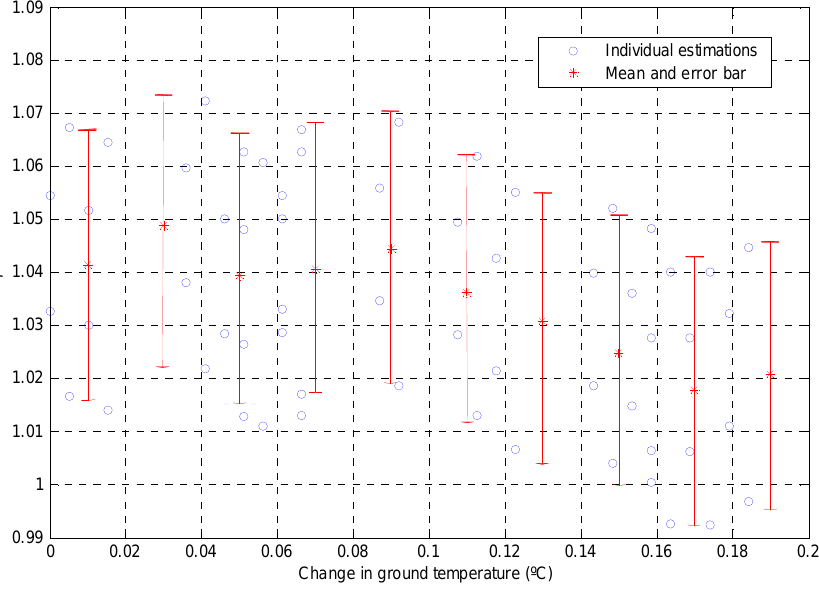
Individual estimations Mean and error